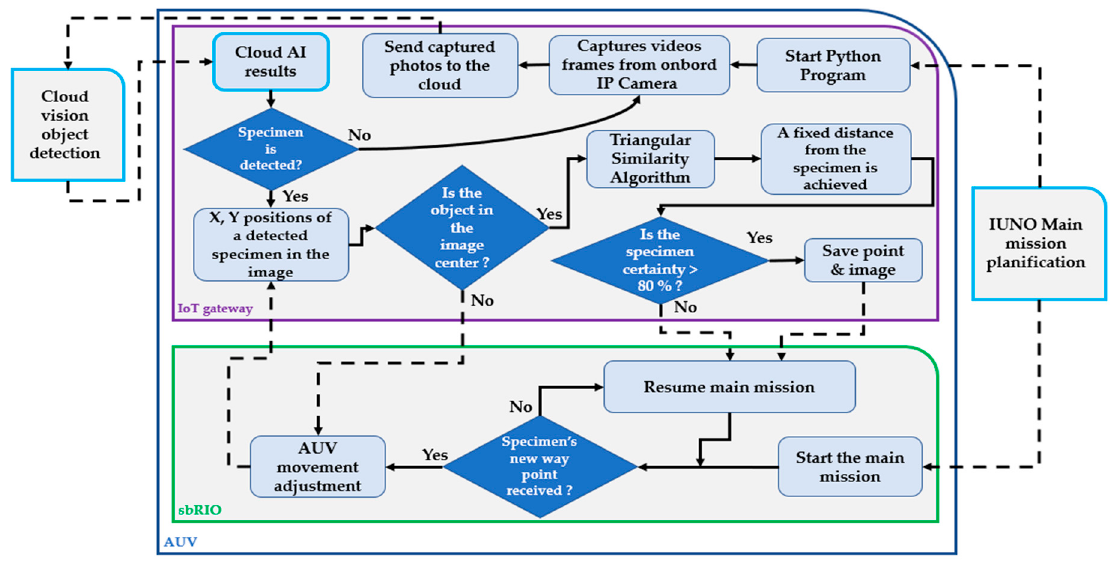
Figure 3. Communication between platforms.